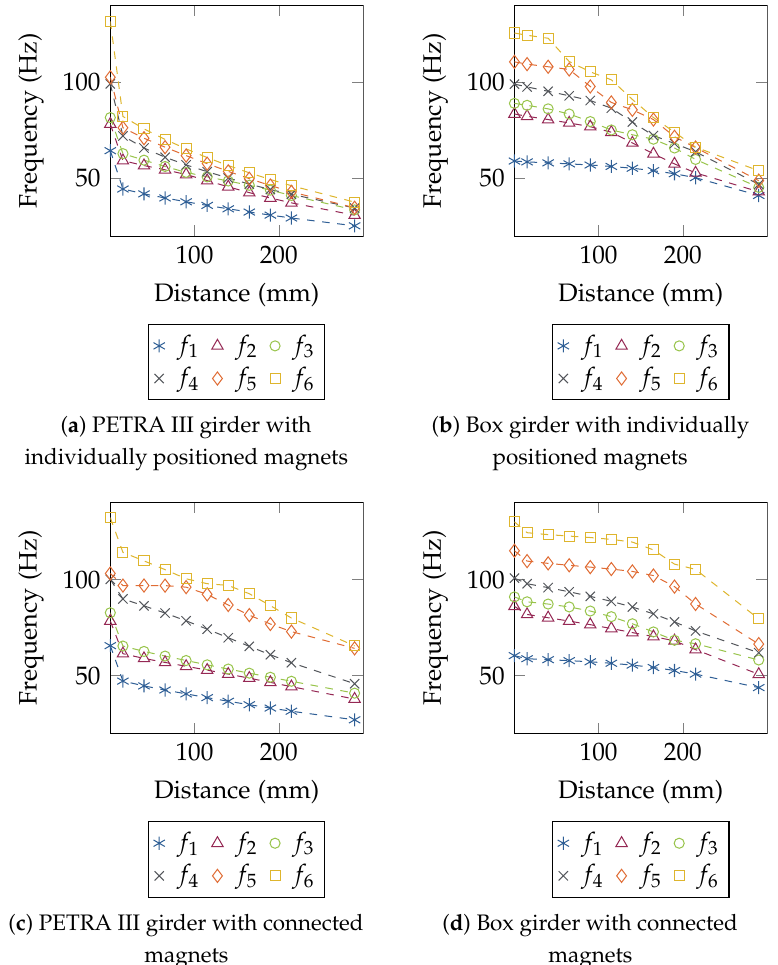
Figure 14. First six eigenfrequencies depending on the distance between girder and magnets for the PETRA III girder ( a ) and the box girder ( b ) with individually positioned magnets as well as for the PETRA III girder ( c ) and the box girder ( d ) with connected